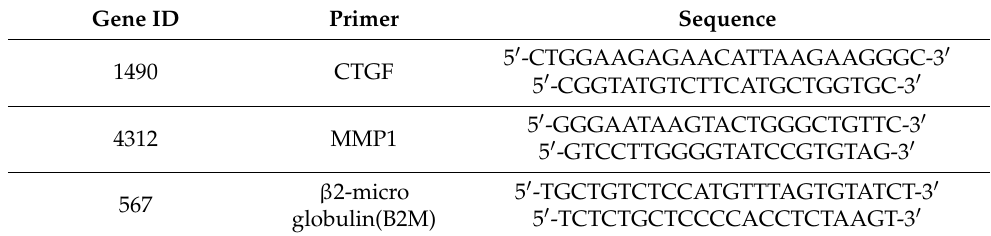
Table 2. Real-time primer